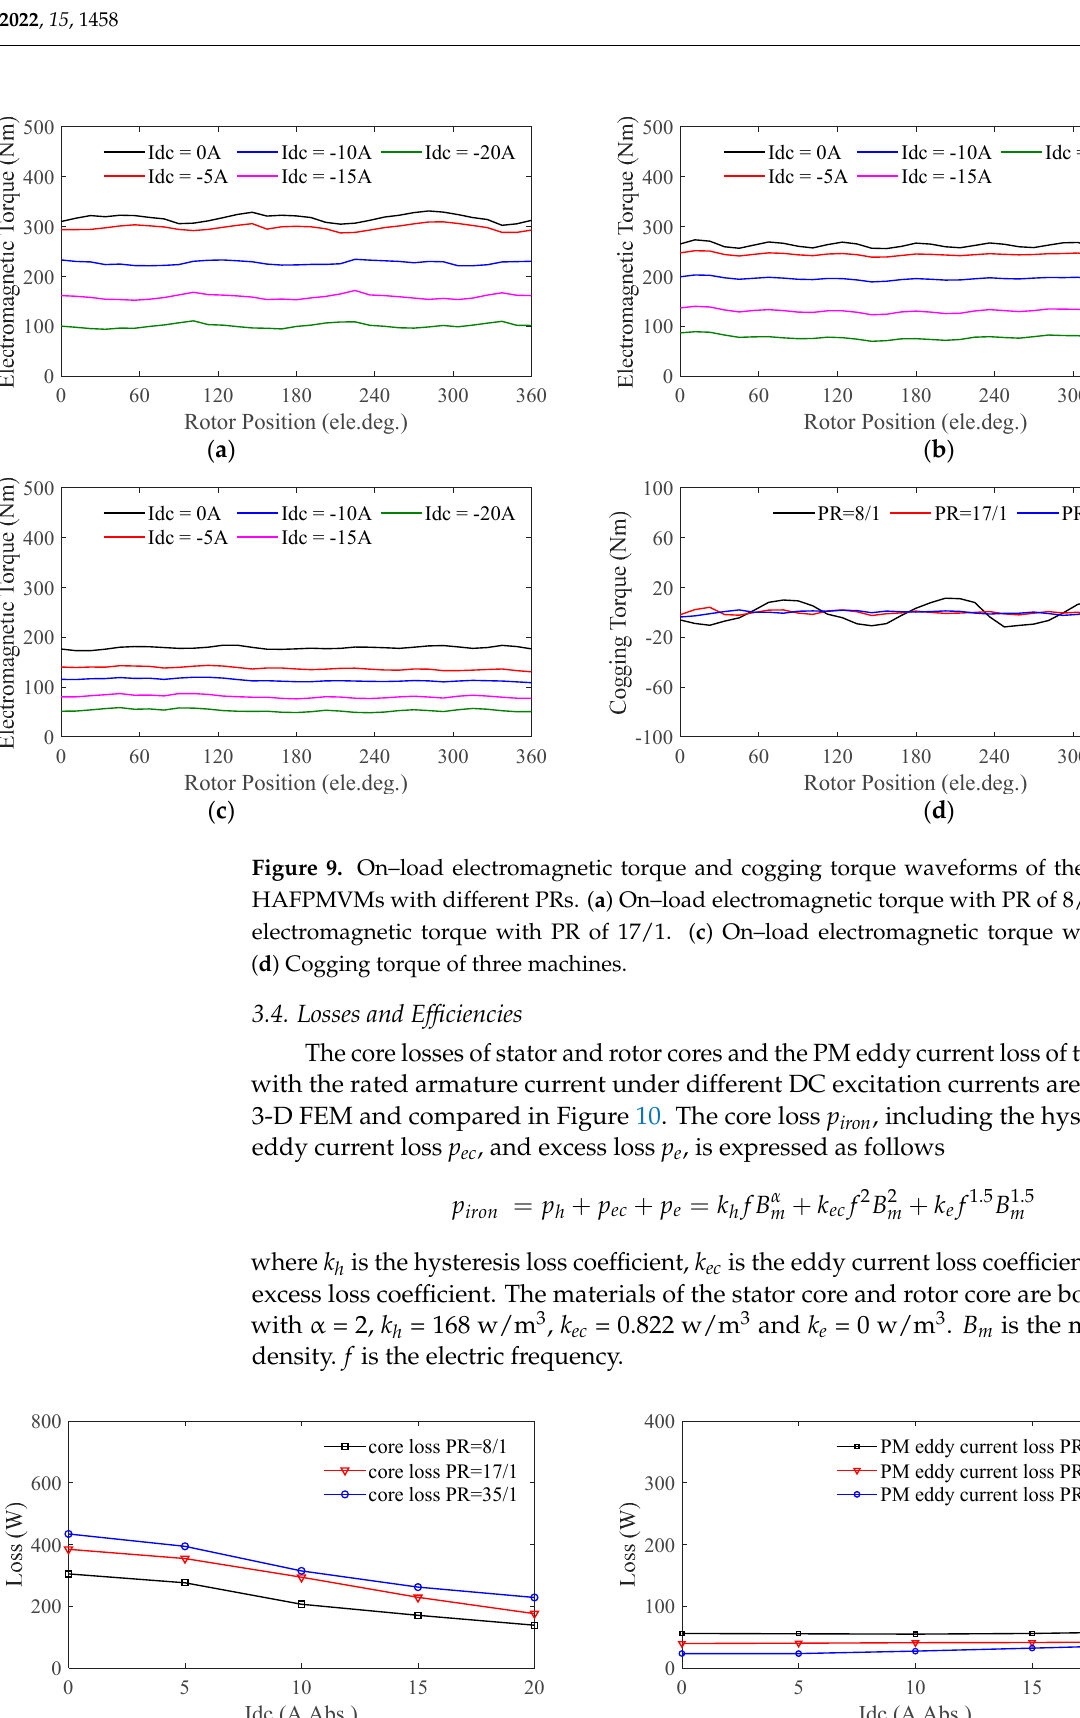
Figure 10. Evolution of losses as Idc under different PRs. ( a ) Core loss. ( b ) PM eddy current loss.